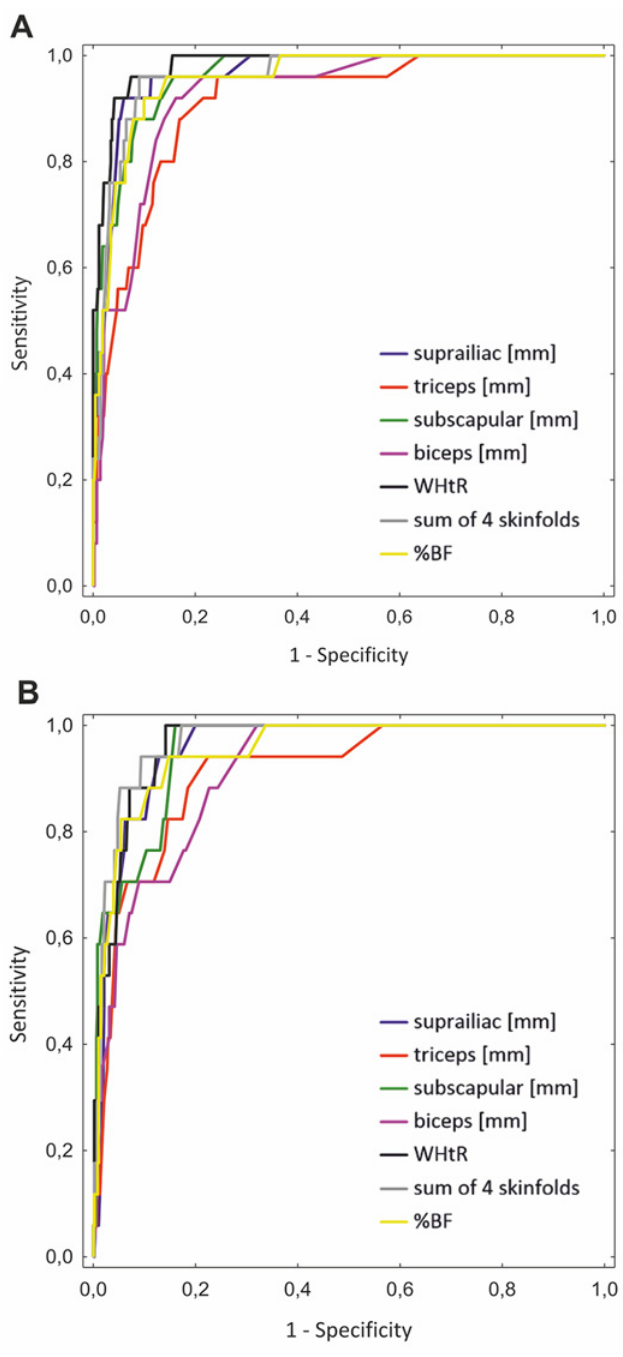
Fig 2. ROC curves for predicting obesity according to the growth reference charts from the 2010 OLAF study [14] obtained for waist-to-height ratio (WHtR), percentage body fat (%BF), biceps, triceps, subscapular, suprailiac skinfolds and their sum. Boys (A), Girls (B).